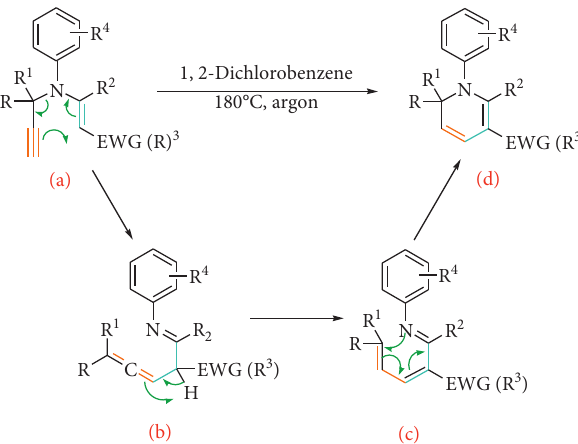
Scheme 3: Proposed mechanism for the formation of 1,2-DHPs. Table 1: Effect of various solvents for the synthesis of 1,2-DHP (f).